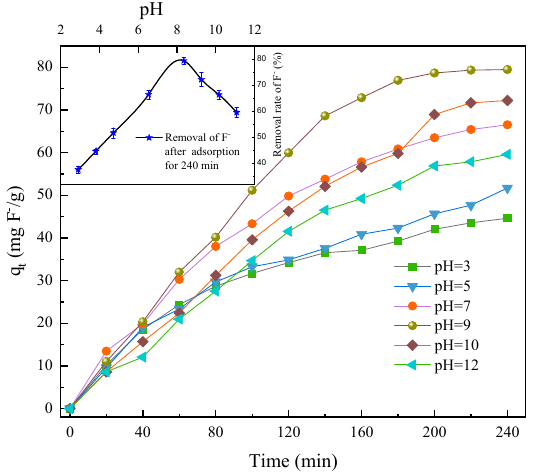
Figure 8. Effect of different pH on removal rate of fluoride ions by the nanosized-manganese oxide/titanium oxide-modified zeolite. The Mn-Ti modified zeolite (2 g) was mixed in a 0.1 L solution with 1 × 10 − 2 g/L initial fluoride concentration at 25 °C and the test time was 4 h.